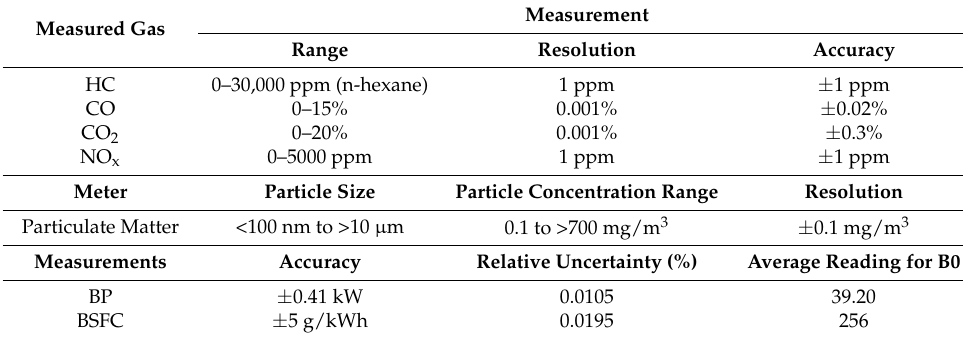
Table 6. Exhaust gas analyser, PM meter specification, and error